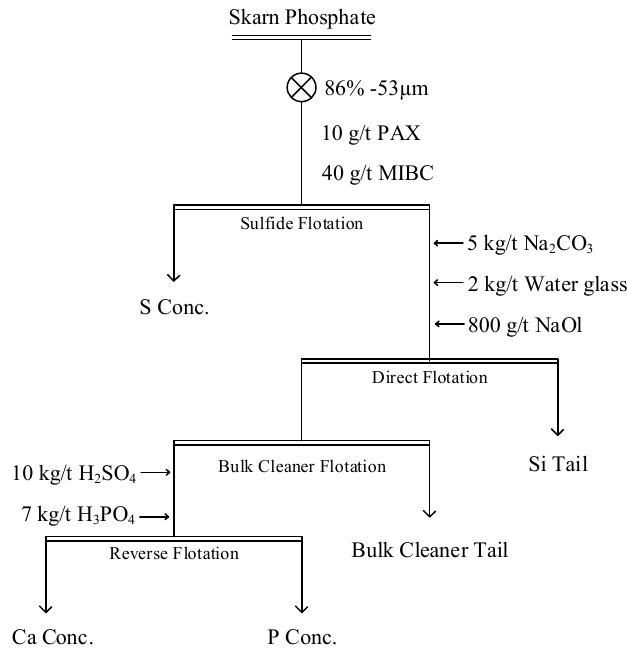
Figure 6. A detailed flowsheet of SP-9 beneficiation test.